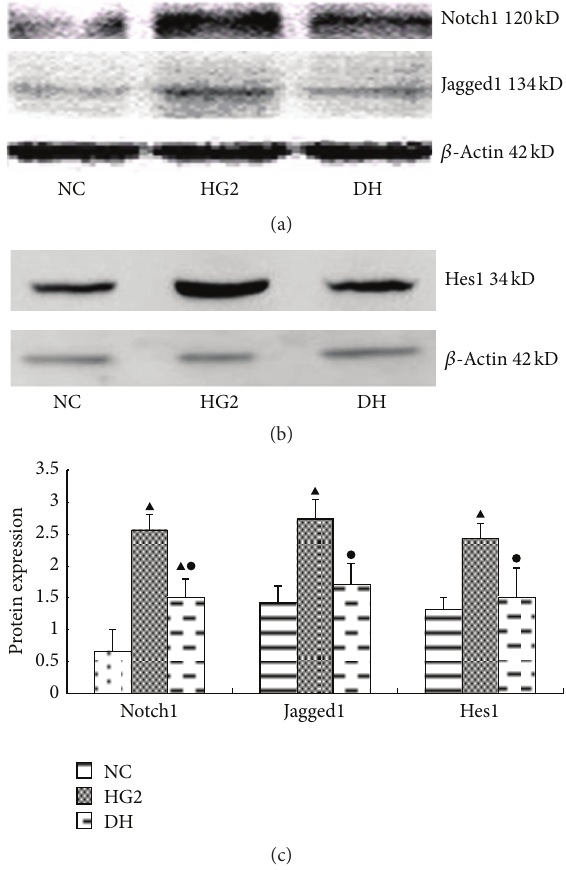
Figure 5: The expression of Notch pathway components after intervention with DAPT determined using western blot for 24 h. (a) Western blot strip chart for Notch1 and Jagged1. (b) Western blot strip chart for Hes1. (c) The gray graph shows the relative statistical values for Notch pathway components in each group. Compared with the NC group, the expression of the Notch pathway components protein was significantly increased in the HG2 group. After DAPT intervention, the protein expression of Notch pathway components decreased. 󳵳 𝑃 < 0.05 versus NC group; ∙ 𝑃 < 0.05 versus HG2 group.